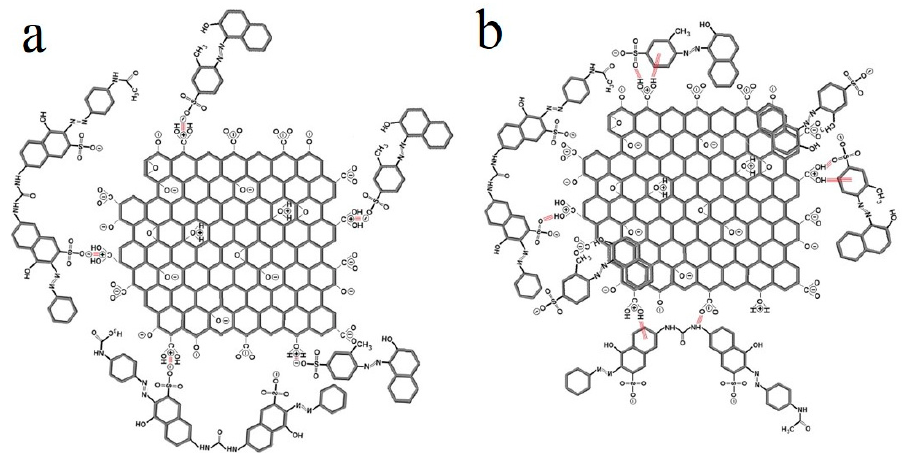
Figure 10. The AO8 and DR23 dyes are adsorbed onto GO via ( a ) electrostatic interaction between the protonated hydroxyl and carboxyl groups of GO and the anionic dyes, and via ( b ) H-bonding and π – π stacking. Reproduced with permission [150]. Copyright 2017, Elsevier.